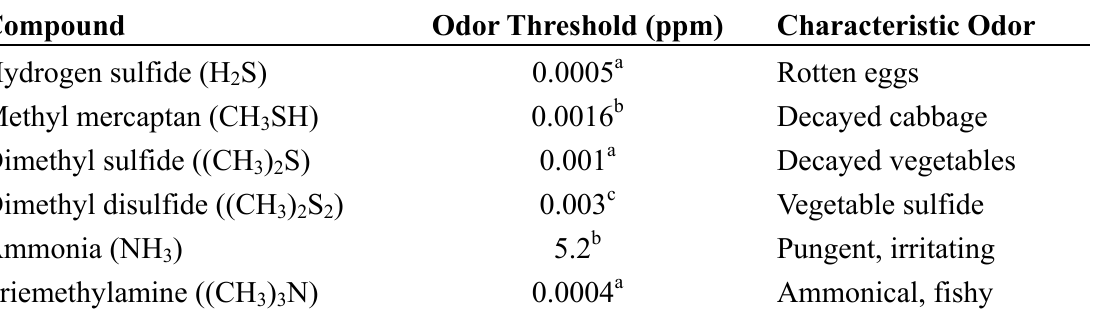
Table 1. Selected Odorous Compounds from Wastewater Treatment Plant and their Corresponding Odor Threshold values.